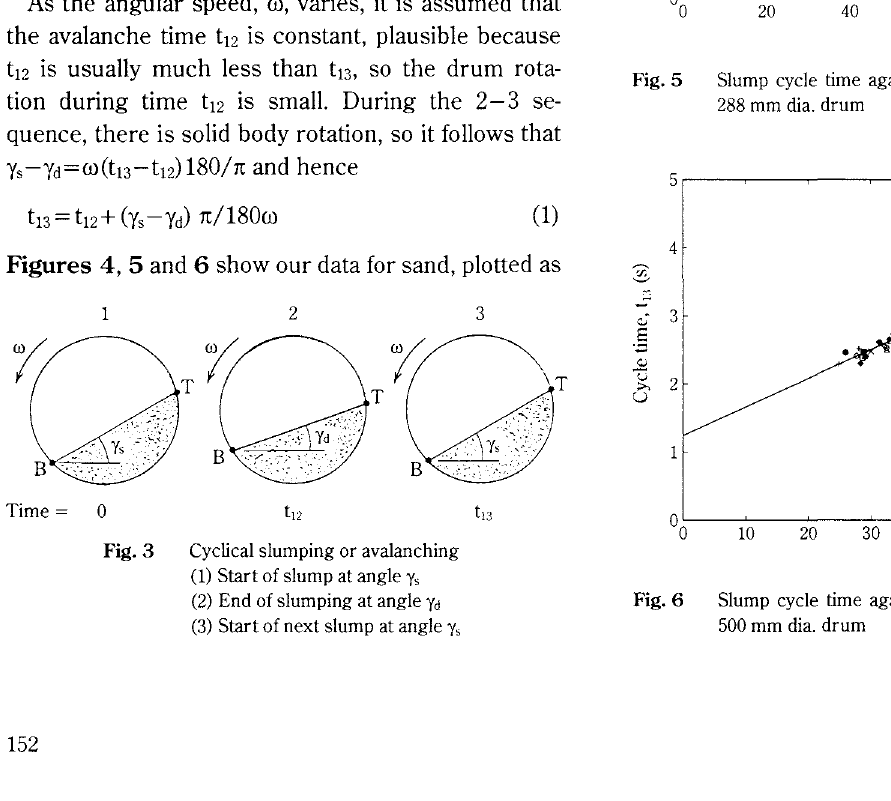
Fig. 5 Slump cycle time against 1/(angular speed) for sand in 288 mm dia. drum